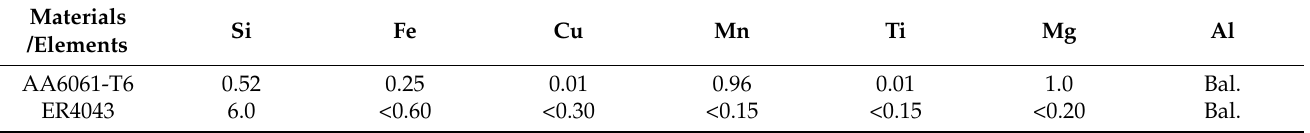
Table 1. Chemical constituents (wt.%) of AA6061-T6 and ER4043.